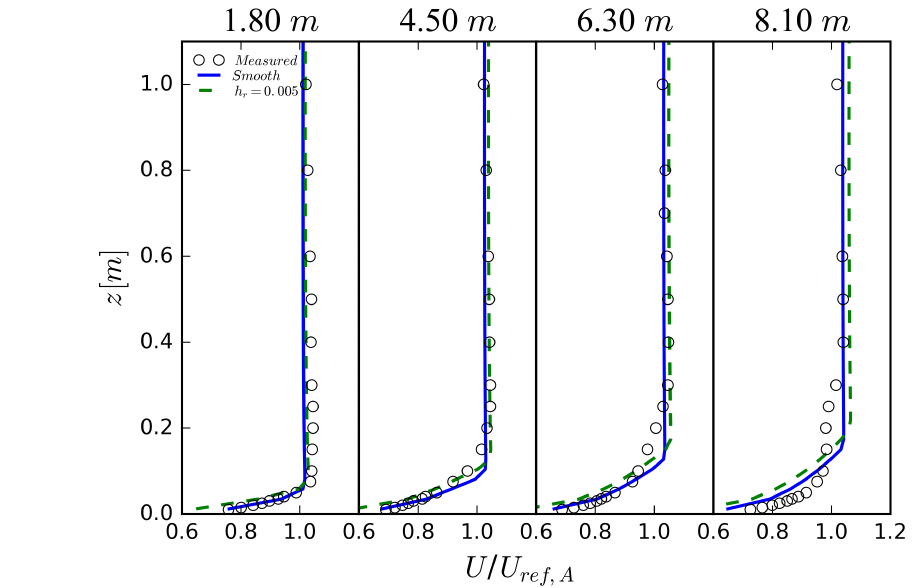
Figure 4. Normalized axial velocity for different wall functions plotted against the experimental data for four downstream distances from the inlet.